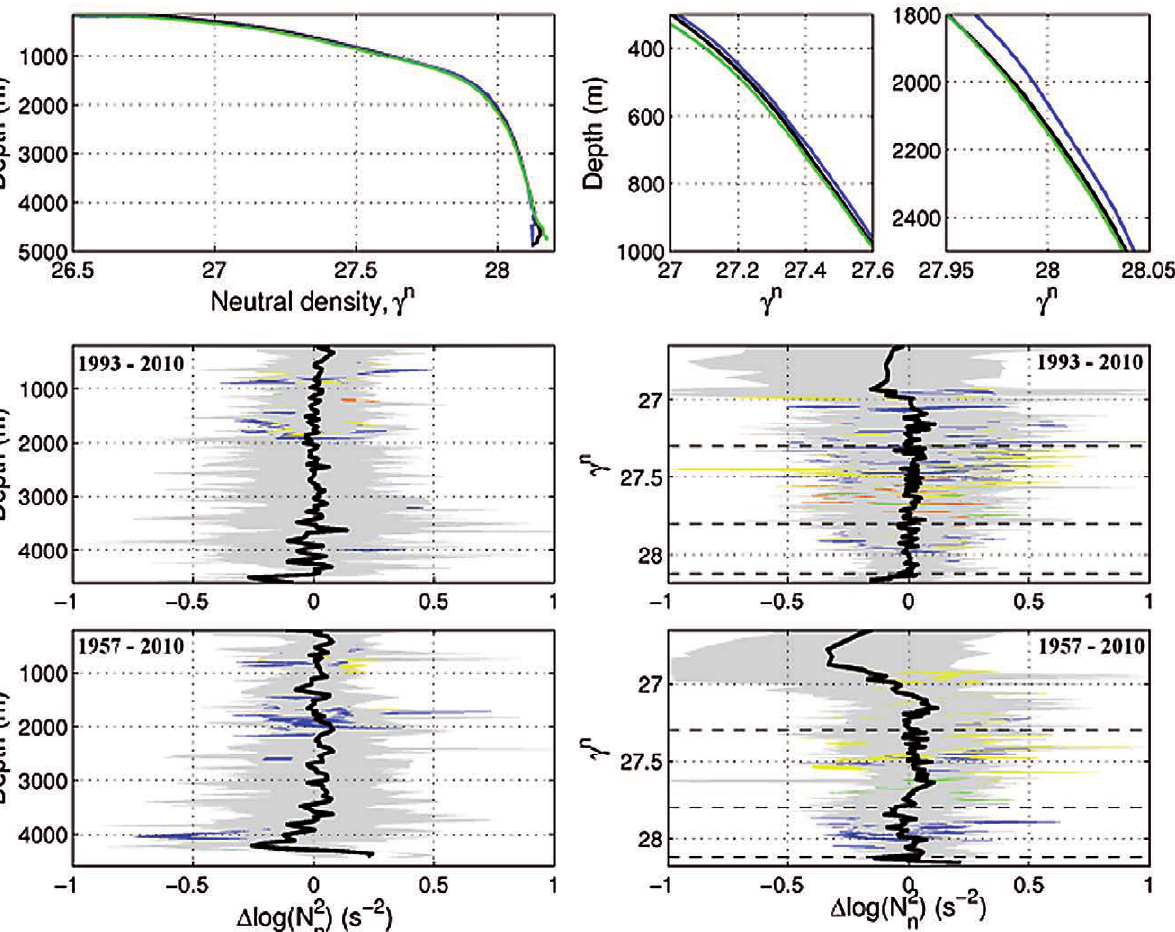
f ig . 13. – The upper panels show the zonally-averaged neutral density for the 1957 (blue), 1993 (black) and 2010 (green) transects. The middle 2 , calculated between 1993 and 2010 and and lower panels show the mean absolute variation of the squared neutral buoyancy frequency, N n between 1957 and 2010 (solid black lines), respectively, plotted on top of all values again coloured according to their Turner angle transitions in these periods (points are depicted in grey and the transitions are colour-coded as in Figure 9). The two left panels show the results in the depth domain, whereas the two right panels show the results in the neutral density domain. In the neutral density domain the levels g n =27.3, 27.8, 28.1 appear dashed in